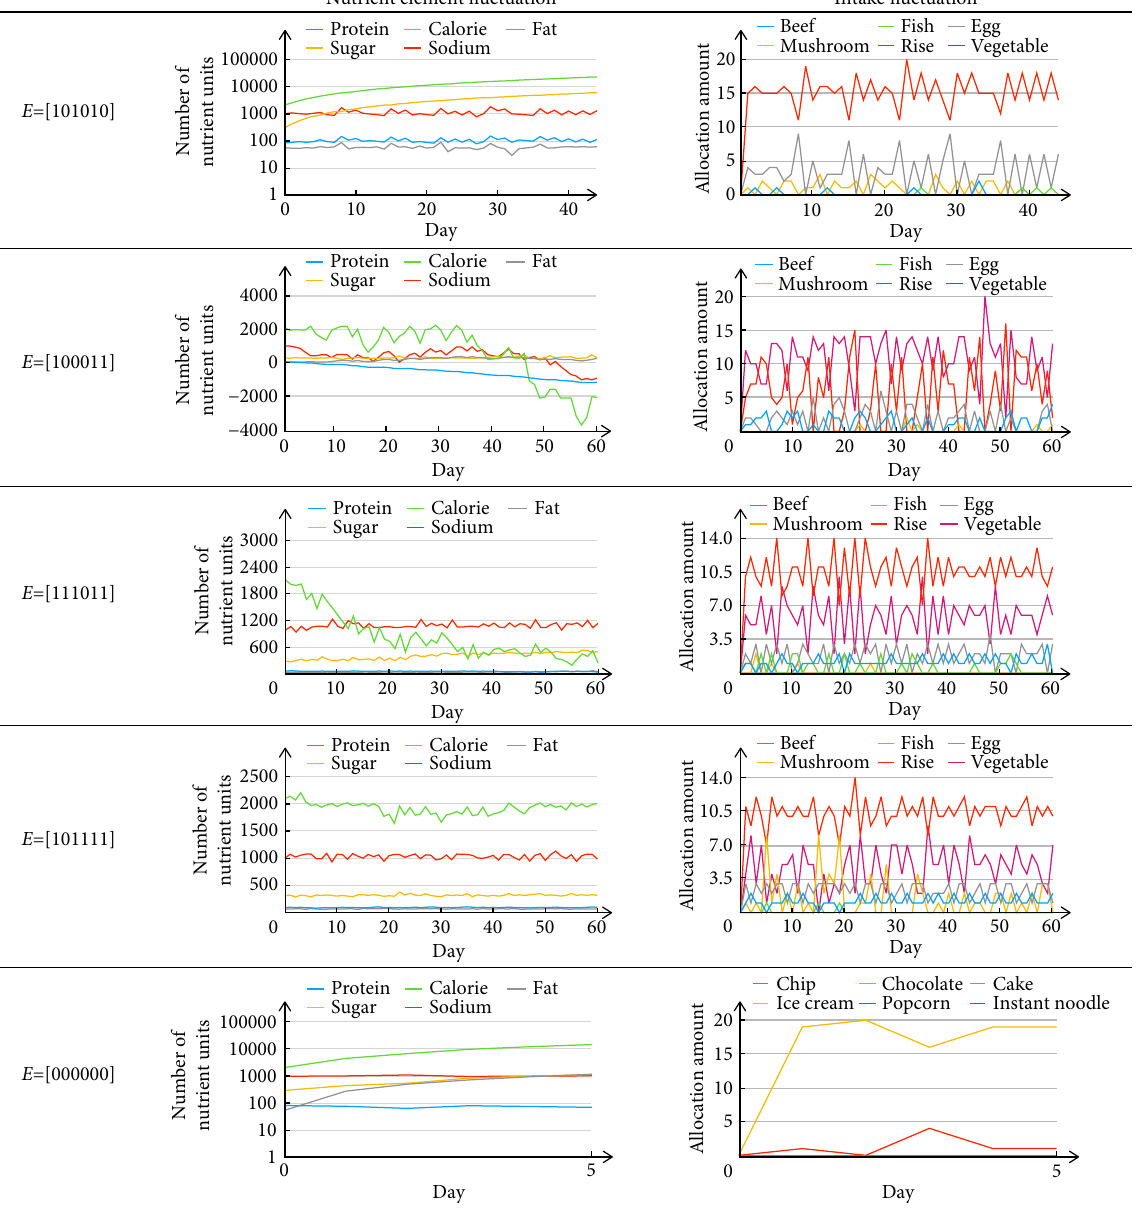
Fig. 3 State change and evolutionary strategy selection of agents in different evolutionary environments.